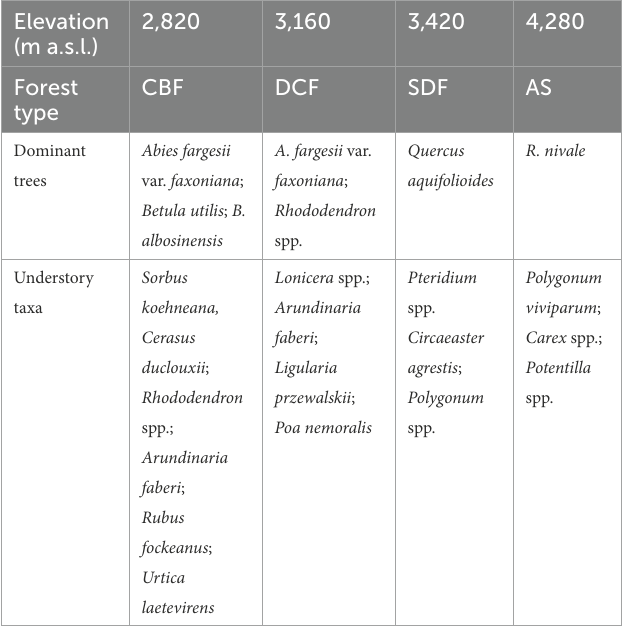
TABLE 1 Dominant plant species composition at different elevations in Wolong Nature Reserve on the eastern Qinghai-Tibetan Plateau. Elevation (m